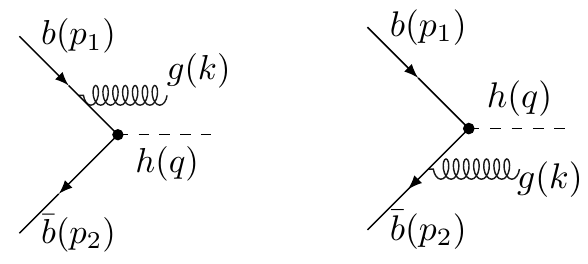
Figure 2 . Real-emission contributions to the production of the Higgs boson in b ¯ b fusion at O ( α s ) . For the calculation in the massive scheme we keep p 2